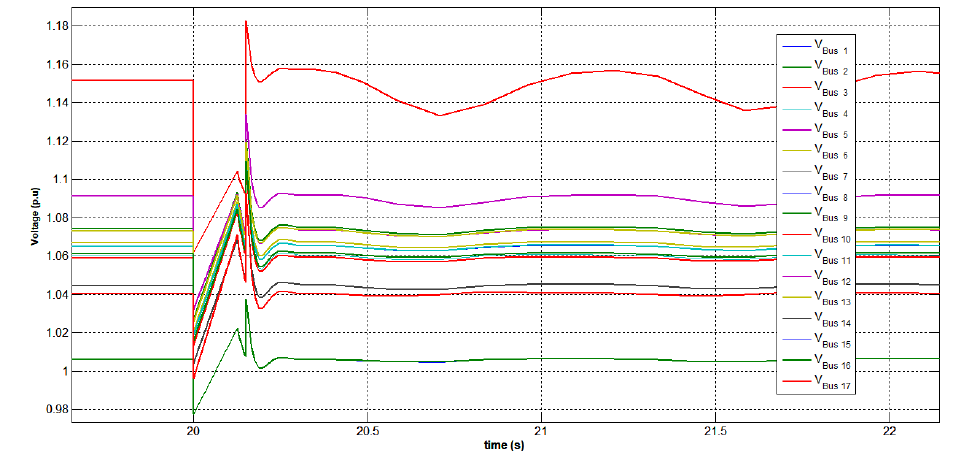
Figure 49. Voltage variation at all buses under a three ‐ phase short circuit at bus 3 with STATCOM.